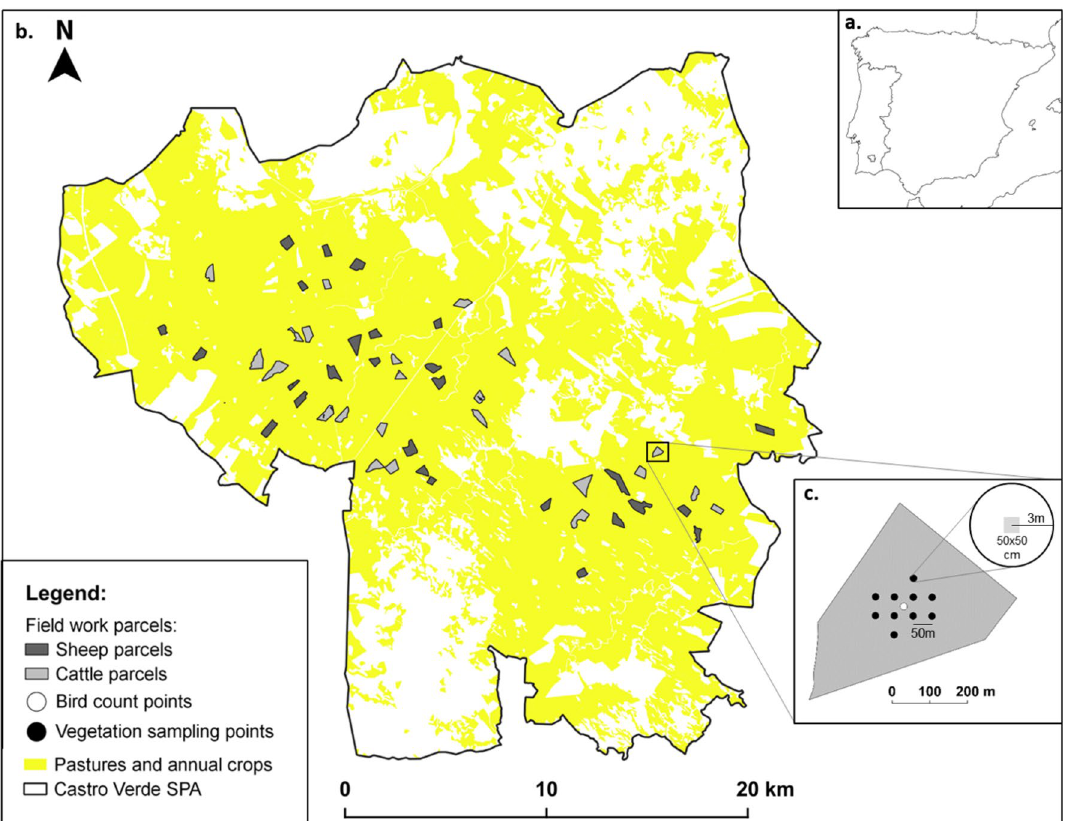
Figure 1. ( a ) Location of the study area within the Castro Verde Special Protected Area (SPA), southern Portugal. ( b ) Distribution of the 27 sheep (dark grey polygons) and 23 cattle (light grey polygons) grazing parcels and ( c ) Sampling scheme applied to each parcel surveyed. Bird counts were done at the centroid of the parcel (white dot) whereas vegetation sampling was performed at the indicated 10 points (black dots). The area covered with pastures and annual crops (derived from CORINE land cover 2018—https:// land. coper nicus. eu/ pan- europ ean/ corine- land- cover/ clc20 18) is shown in yellow. The map was done using the version 3.10.0 of QGIS—https:// qgis. org/ en/ site/ index. within 3 cm of the ruler 20 . All values were estimated to the nearest half centimeter. When no vegetation was pre- sent (bare soil, soil litter, rocks or animal dung) the height was set to zero (0) but these measurements were not considered to estimate the mean height of the sward. Vegetation cover was measured inside a 50 × 50 cm quadrat placed at each of the ten grid points, by visual estimation to the nearest 5% of the percentage of the quadrat area covered by vegetation 21 (Fig. 1). Vegetation height and cover measurements were averaged within each parcel. Grazing regime. The number and type of livestock in each parcel as well as the extent of the grazing period since the start of the year (2019) were gathered from interviews (Supplementary Information S1) to land manag- ers during 1–15 May 2019. This information was further validated, and corrected in a few cases, through field checks during regular visits (made at two-week intervals) to the parcels (see “Bird and vegetation data” section from Methods). Three grazing regime indicators were estimated for the whole period (January–May 2019): livestock type (either sheep or cattle), animal density, and grazing pressure. The animal density in each parcel was calculated as the average density (animals per hectare) of any species (regardless of being sheep or cattle) that grazed the parcel during the 5-months period. Stocking Rate translated animal density into livestock unit (LU) per hectare (LU/ha), between January and May, according to the following criteria: one adult bovine = 1 LU; bovine aged < 6 months = 0.4 LU; one adult sheep = 0.15 LU 22 . Using LUs allows the comparison of densities across livestock types after correcting for their relative feeding requirements 23 . Grazing Pressure was estimated as the Stocking Rate times the number of days a number of Livestock Units (LU) spent in a plot (LU/ha × num- ber of days) 24 . The area used for these estimations corresponded to the available area where animals could freely roam, which in many cases was larger than the sampled parcel area, which was often not delimited by fences. The number of days in the parcel was collected mainly from the interviews. However, in some cases the extent of grazing period was expressed qualitatively and thus had to be inferred, from common expressions accord- ing to the following criteria: ‘few’ = 5 days, ‘some’ = 10 days, ‘a fortnight’ = 15 days, ‘many’ = 20 days, ‘almost all month’ = 25 days 25 .